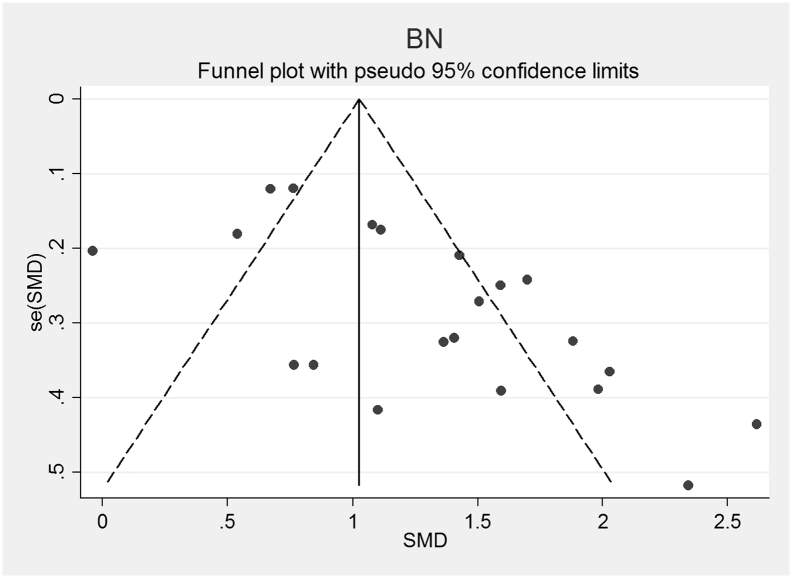
Funnel plot of Bulimia Nervosa (BN) studies included in the meta-analysis to assess for publication bias. Each dot represents a study included in the meta-analysis, with the Y axis representing the size of each study and the X axis, each study's result.